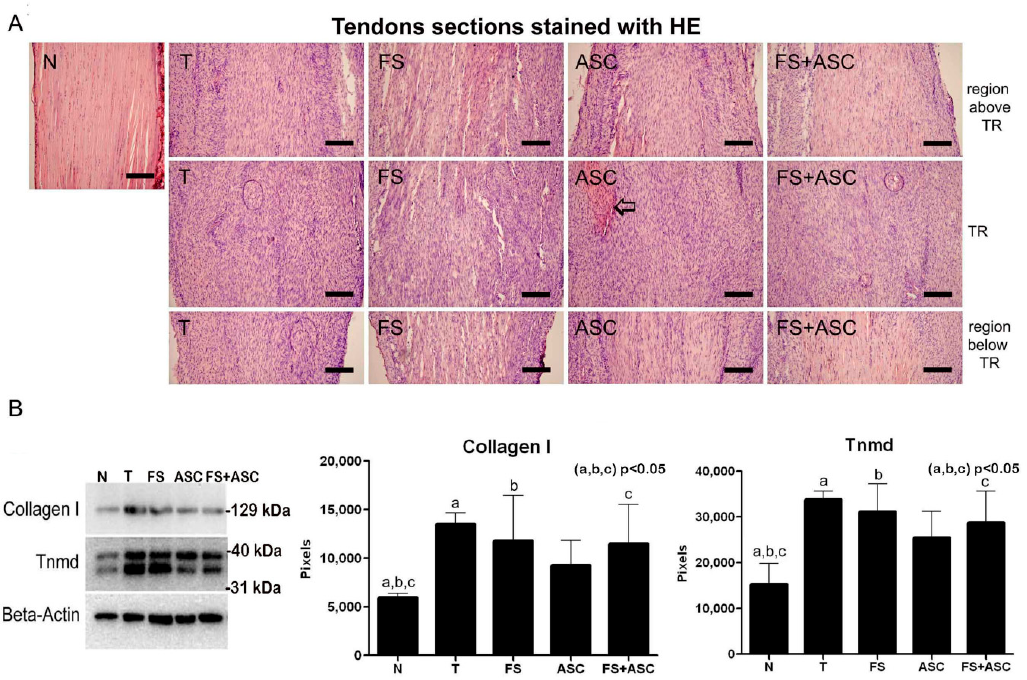
Table 1. Hydroxyproline concentration (mg / g tissue) in the entire tendon (n = 8). (*) Significant di ff erence between N and ASC groups.